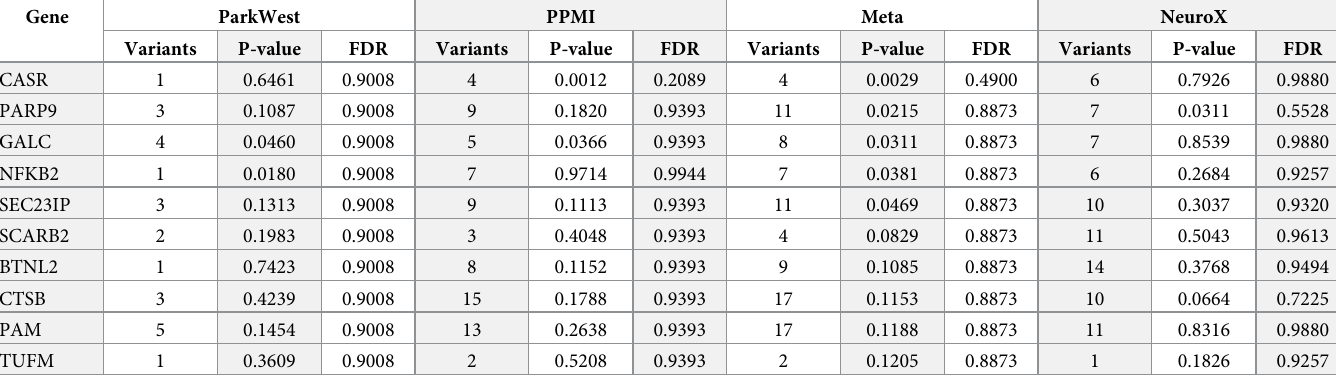
Table 2. Top results from SKAT-based gene enrichment